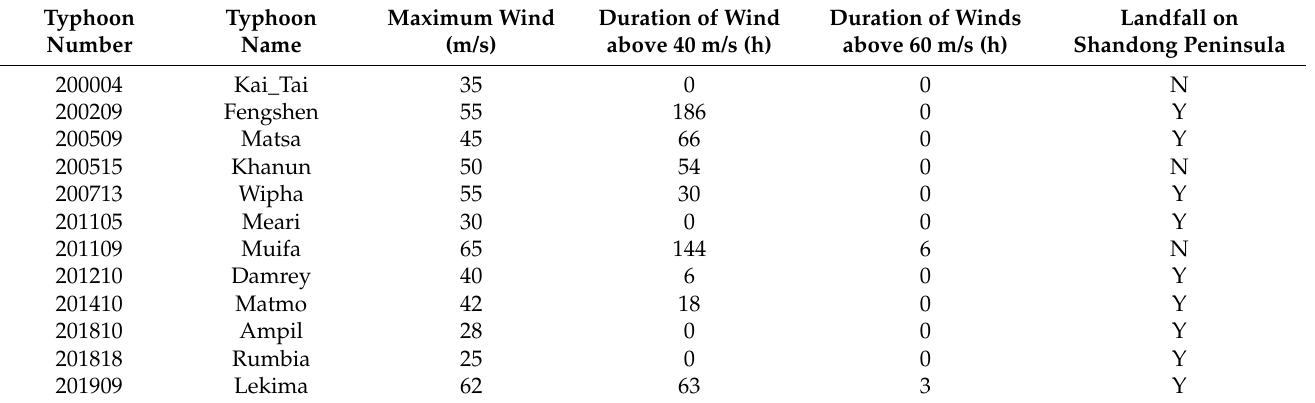
Table 1. Maximum wind speed, strong wind duration, and landfall information for 12 typhoons that have passed through the Northern East China Sea. Data is from CMA Tropical Cyclone Data Center